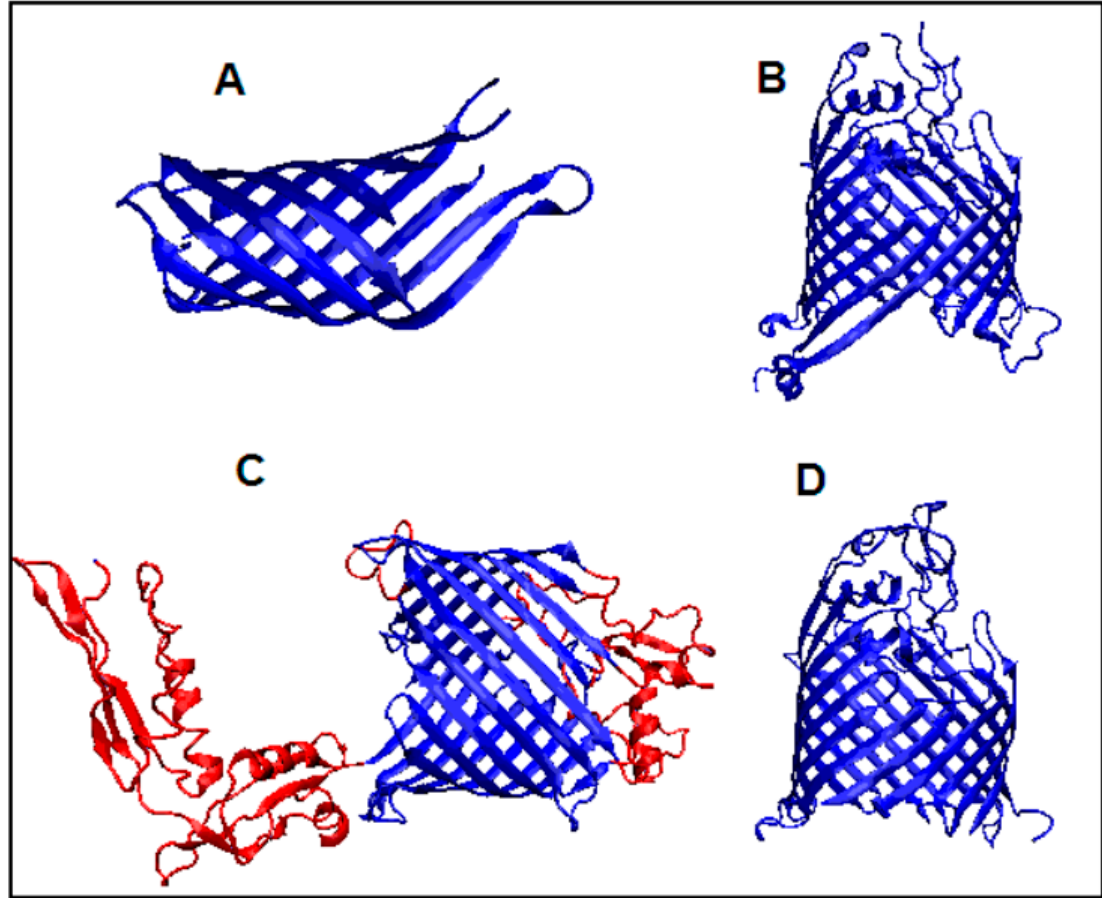
Figure 7. 3D presentation of the following proteins: ( A ) 1QJP, ( B ) 6FSU, ( C ) 4K3C with out-of-barrel fragments highlighted in red, and ( D ) 4N75.